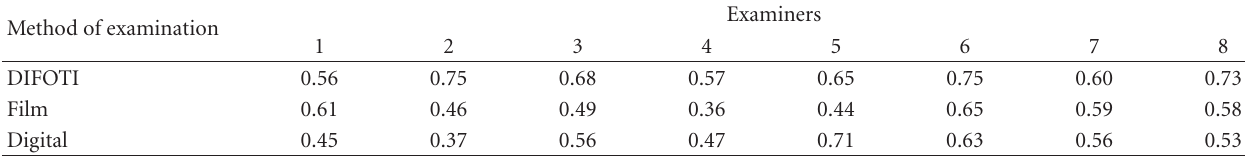
Figure 4: Two sets of images (a) DIFOTI image and (b) digital radiograph of lesion with reference standard score 1. (c) DIFOTI image and (d) digital radiograph of lesion with reference standard score 3. Table 4: Agreement with reference standard. The table presents weighted kappa